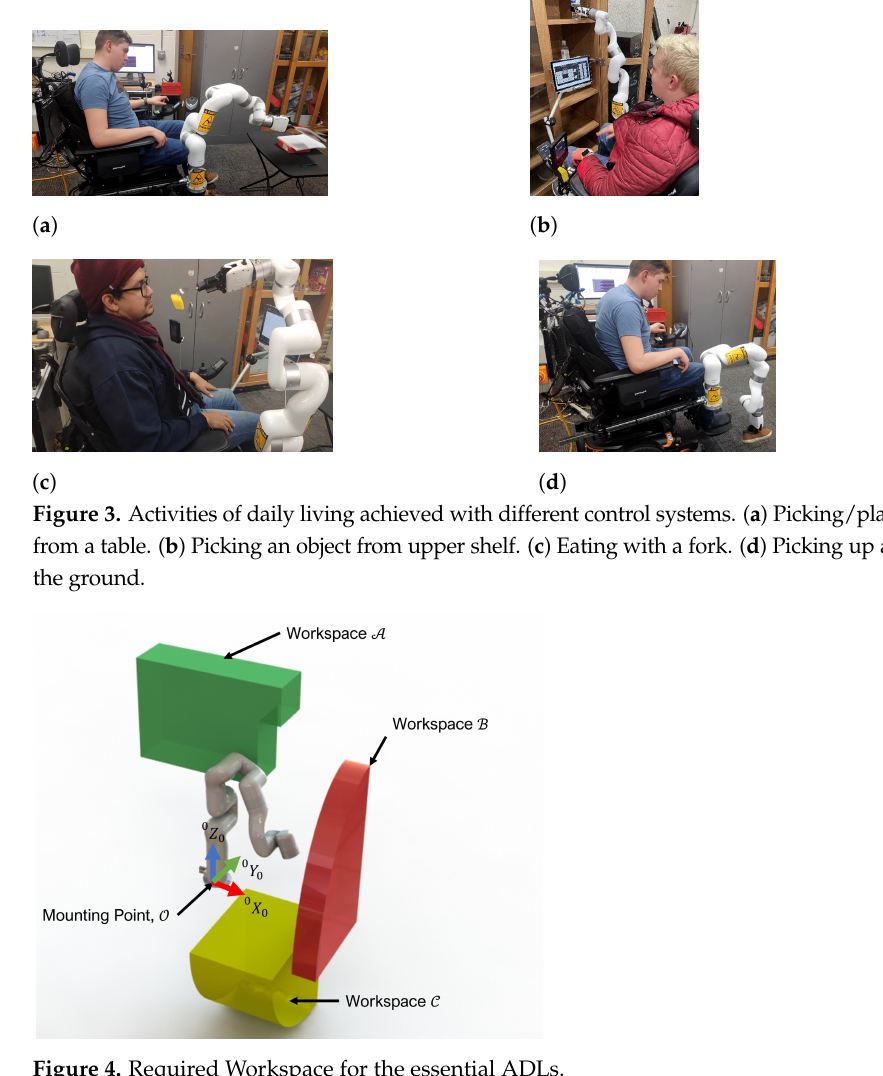
Figure 4. Required Workspace for the essential ADLs. Table 2. Aimed ADLs of each